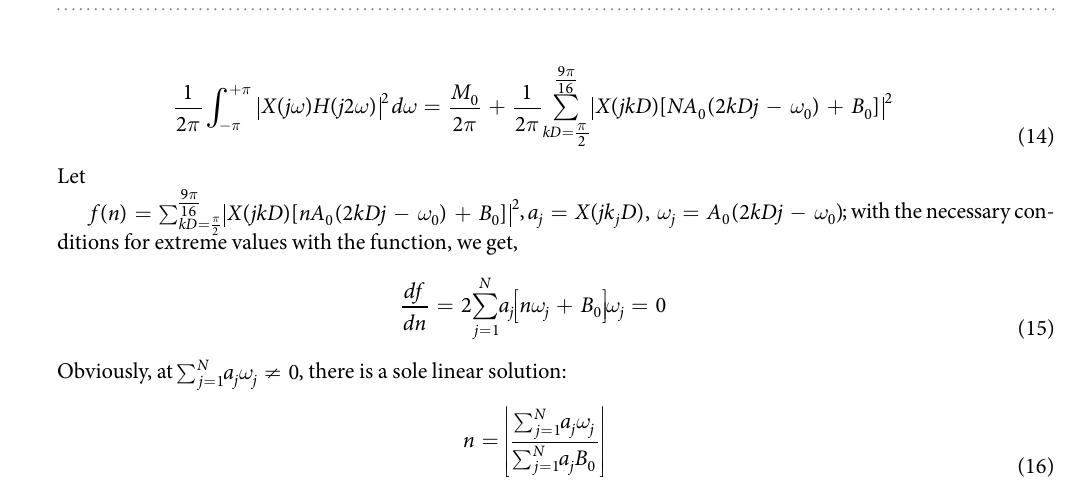
Figure 2. Real-time ECG image ( a ), and its frequency characteristics ( b